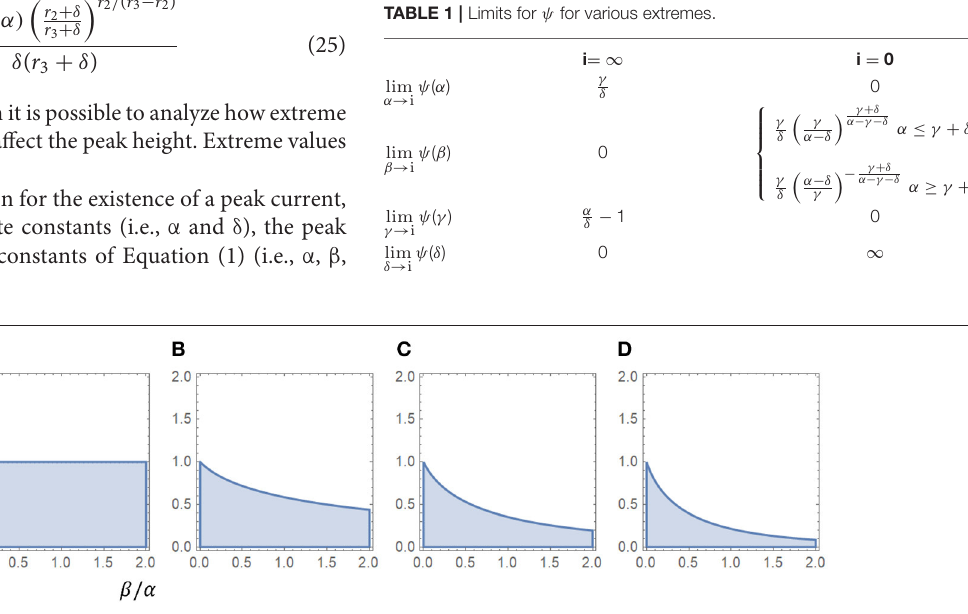
FIGURE 1 | Regions associated with a peak in the β − δ plane ( α = 1). The existence of a peak was independent of the value of γ , as long as γ > 0, for all cases. (A) One closed state ( α > δ ). (B) Two closed states. (C) Three closed states. (D) Four closed states.